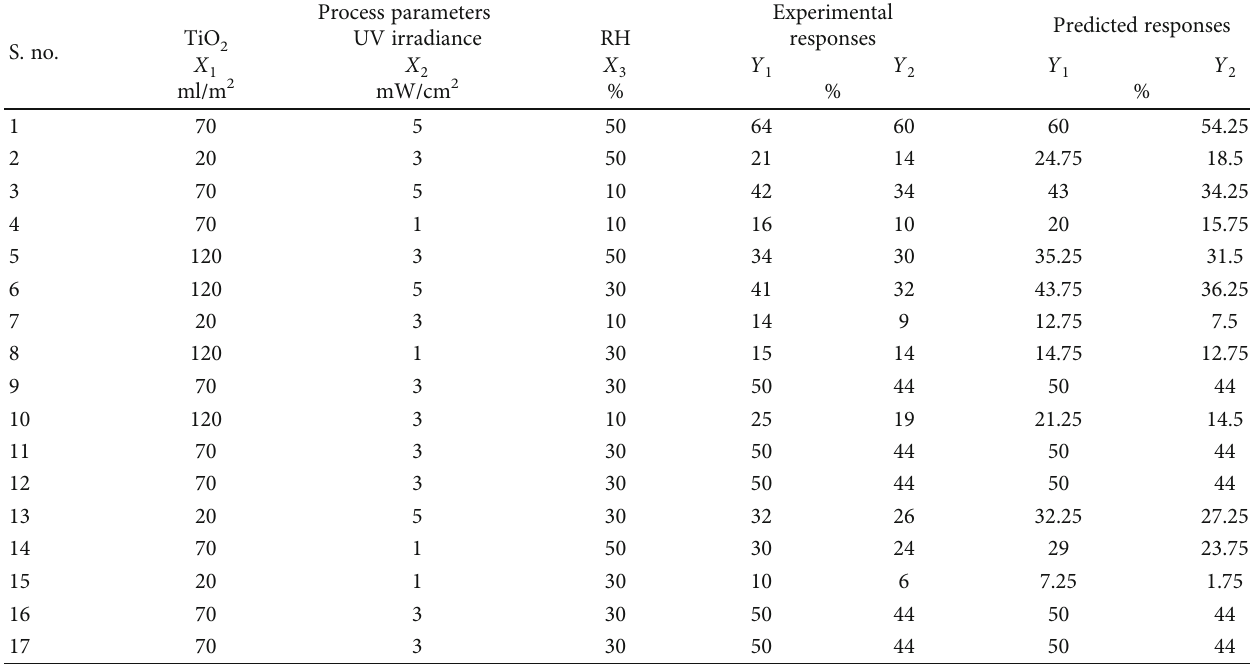
Table 2: Comparison of experimental and predicted responses.